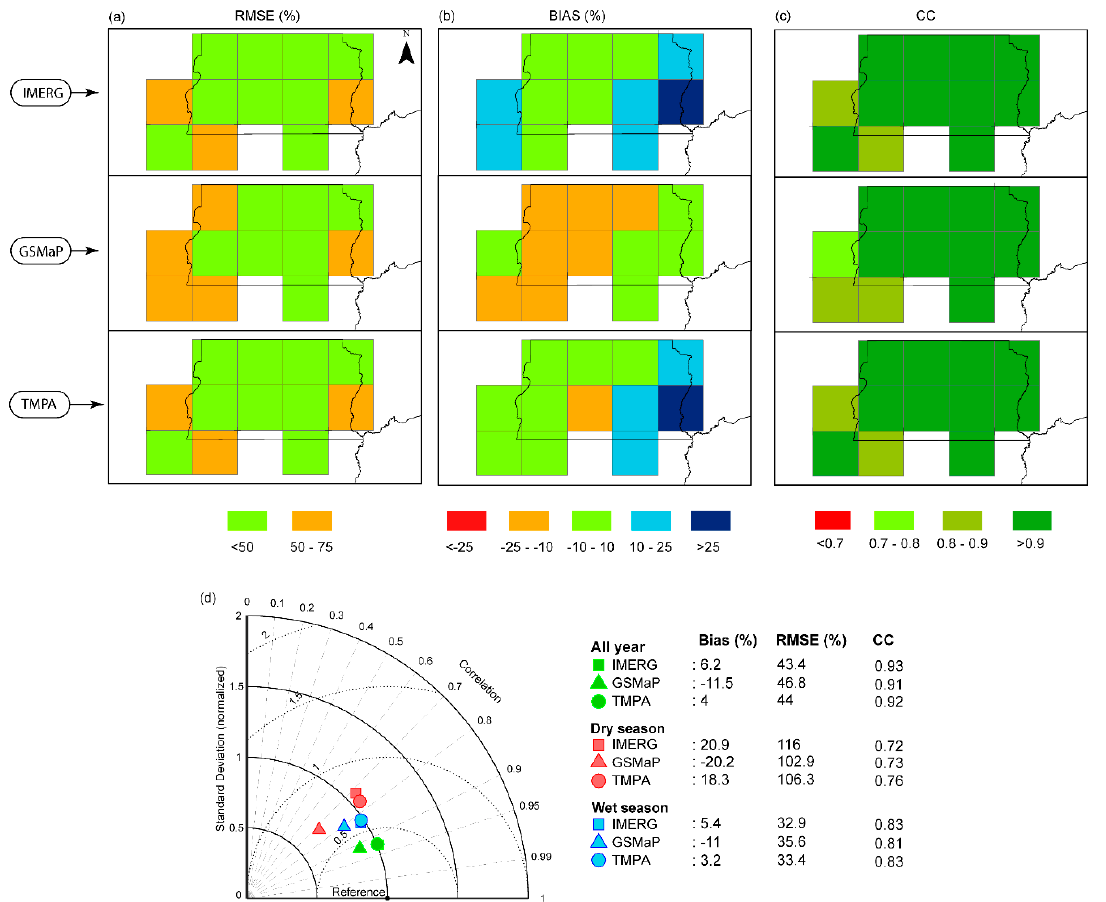
Figure 4. Study area: local percent root-mean-square error (%RMSE) ( a ), percent bias (%B) ( b ), and correlation coefficient (CC); ( c ) for IMERG, GSMaP, and TMPA for the inter-seasonal scale, and Taylor diagram using the Mean Monthly datasets ( d ).